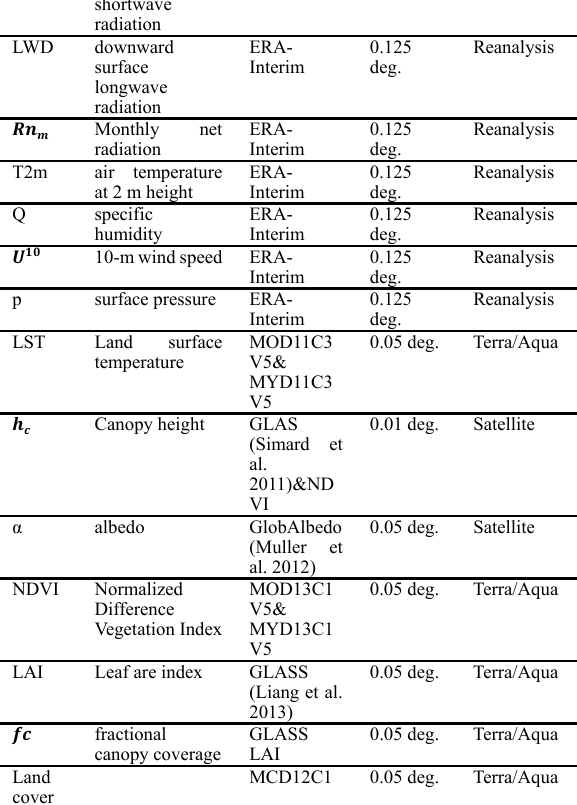
Table 1 input data sets used for the et